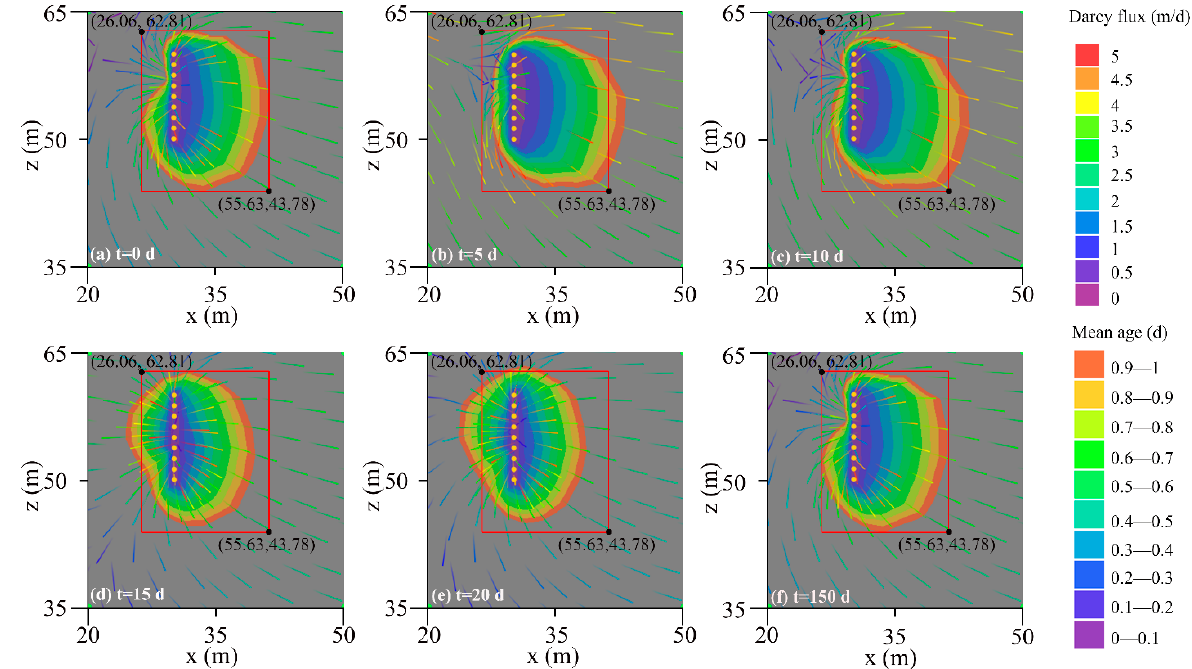
Figure 5. The variation of the artificially recharged water lens is driven by the fluctuating surface water level in the artificially recharged near-bank aquifer. The yellow points are injection nodes, representing the screen of the injection well. ( a ) is for t = 0 d. ( b ) is for t = 5 d. ( c ) is for t = 10 d. ( d ) is for t = 15 d. ( e ) if for t = 20 d. ( f ) is for t = 150 d.